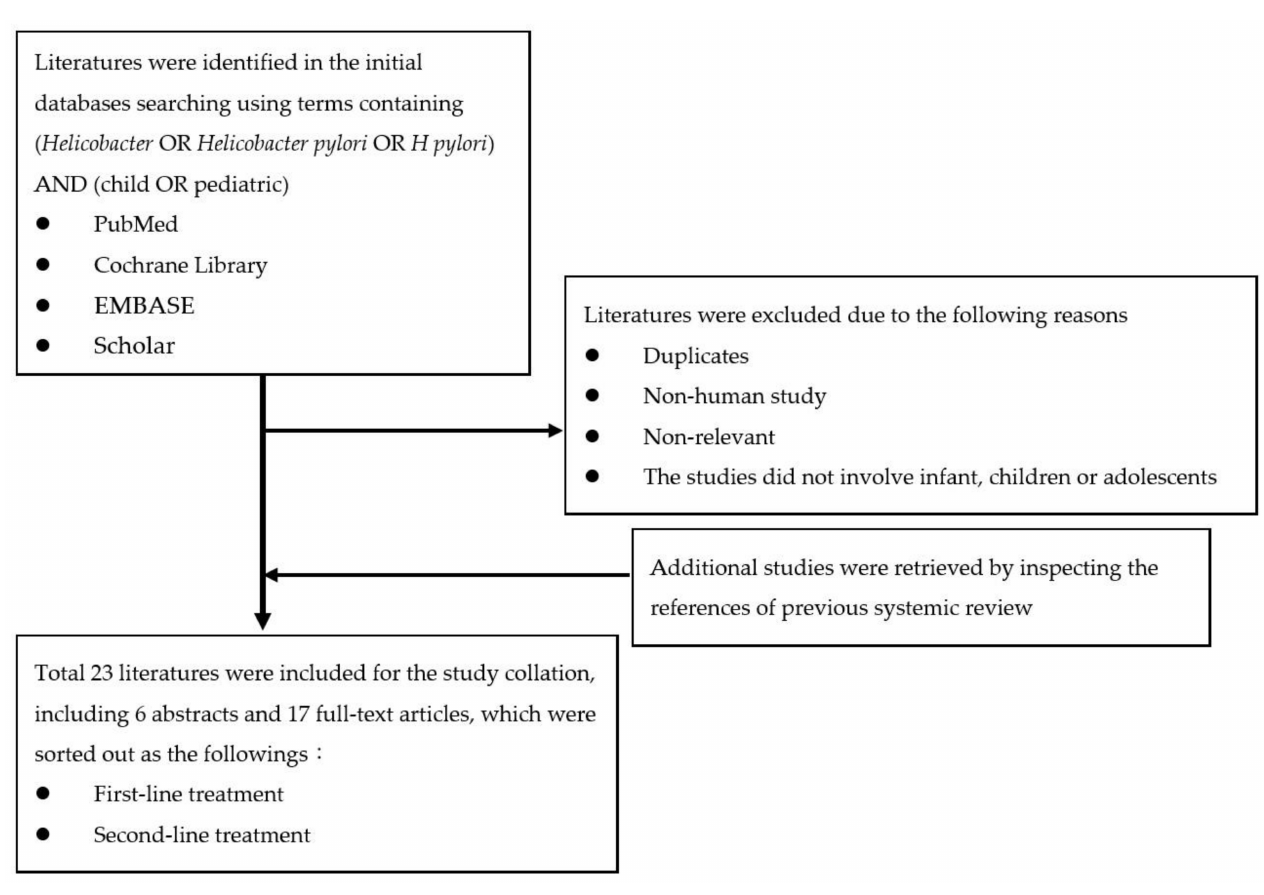
Figure 1. The flow chart of literature selection.